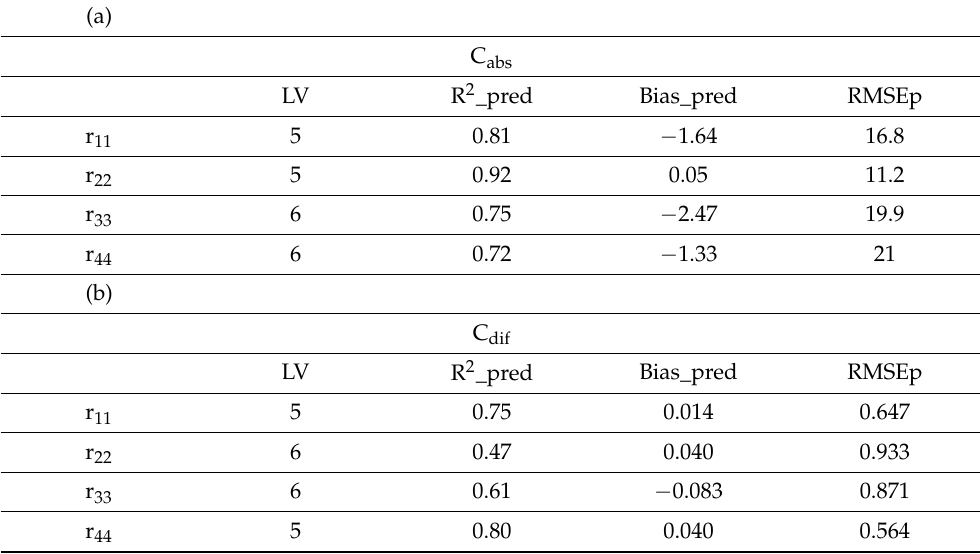
Table 3. Model performances built from the diagonal elements of the Mueller matrix for (a) C abs (absorber concentrations) and (b) C dif (scatterer